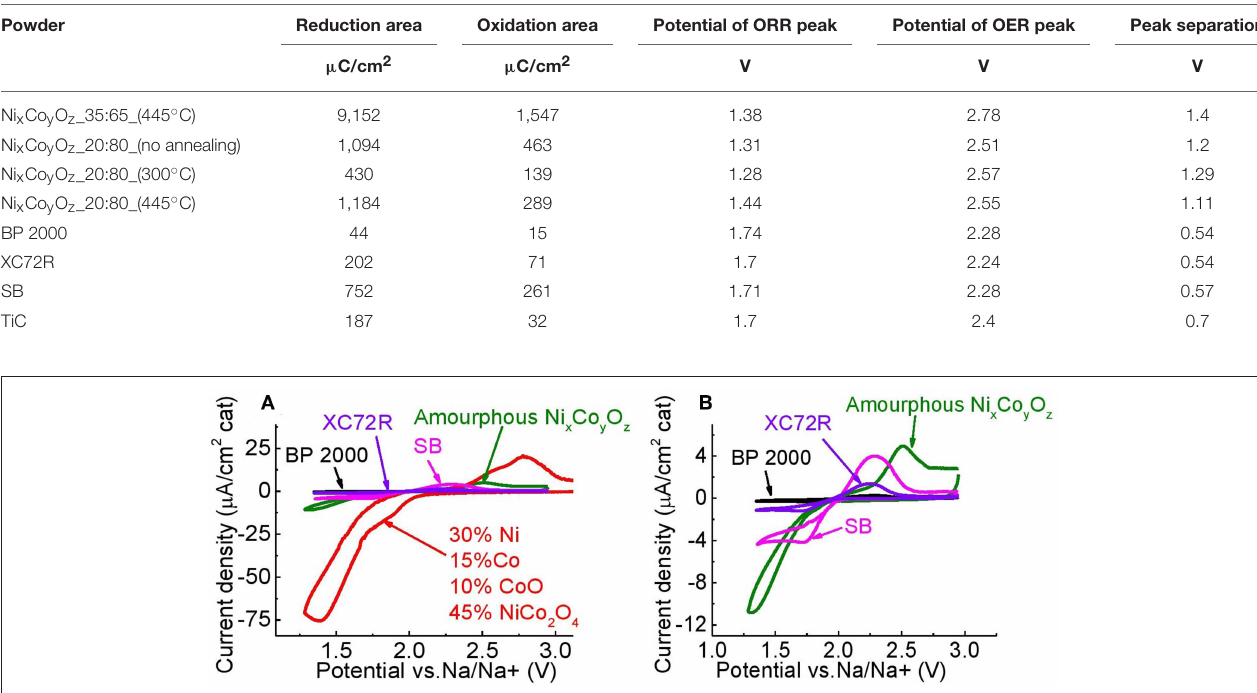
TABLE 2 | Summary of reduction and oxidation areas for the examined powders, and separation of ORR and OER peaks. Powder